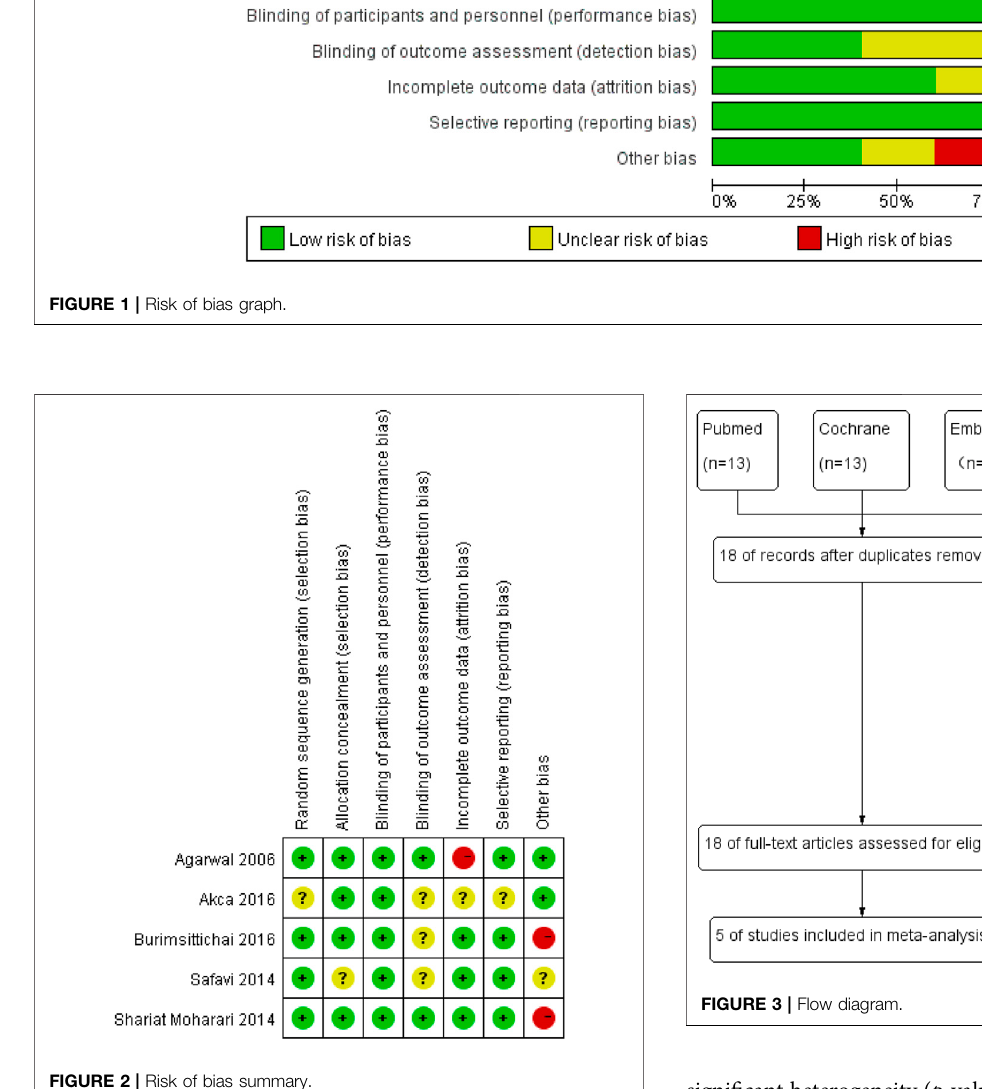
FIGURE 2 | Risk of bias summary.